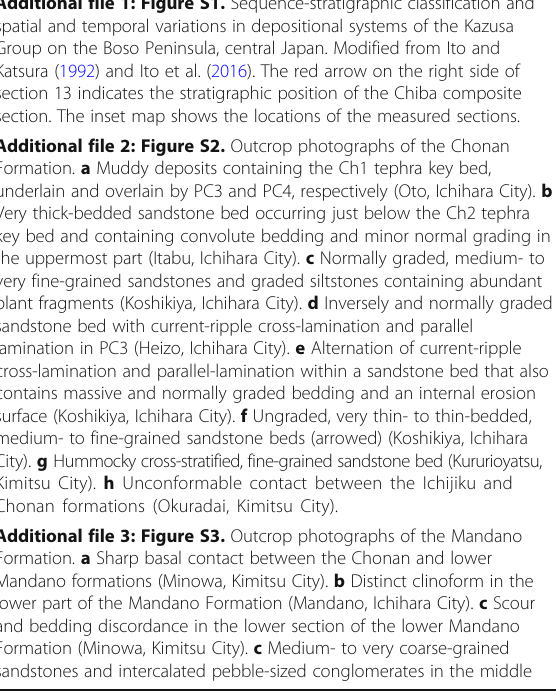
Additional file 6: Figure S6. Outcrop photographs of the lithofacies types summarized in Table 1. Solid white and black arrows indicate